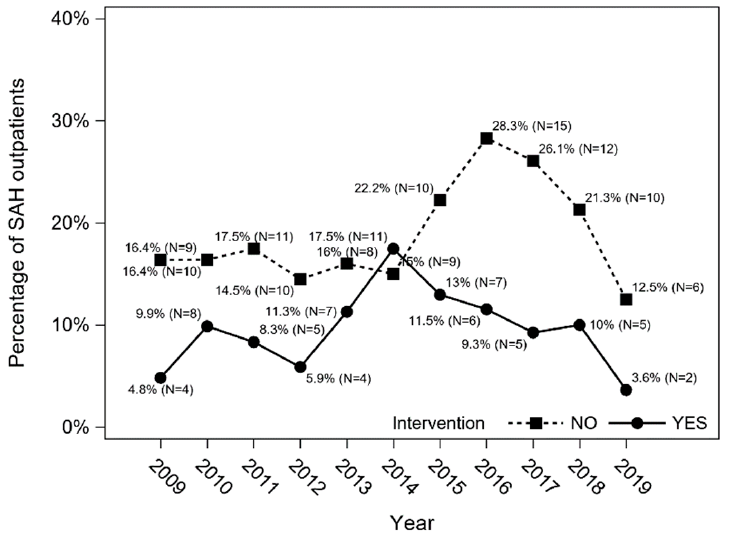
Figure 7. The post-discharge 12-month mortality in patients treated conservatively and in patients who underwent intervention (Cochran–Armitage trend test with Holm–Bonferroni correction: p = 0.529 and p = 0.617, respectively).